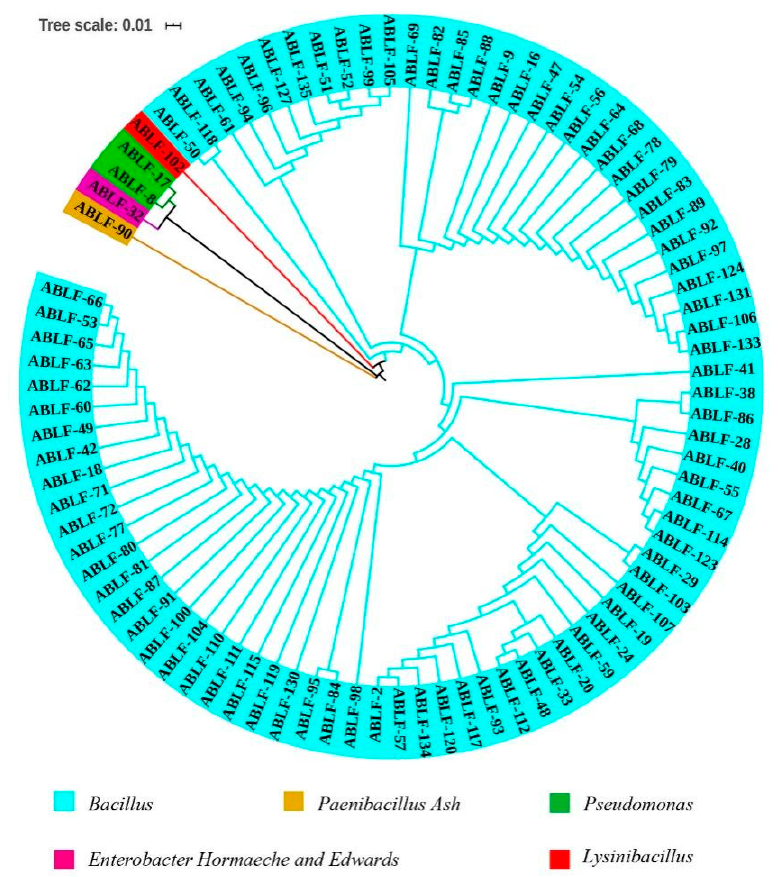
Figure 1. Phylogenetic analysis of candidate antagonistic bacteria against V. dahliae . The 16S rRNA sequences were aligned by ClustalW and phylogenetic tree was constructed with MEGA software (version 7.0, Temple University, Philadelphia, PA, USA) by the neighbor-joining method for 500 bootstraps. Bar 0.01 substitutions per nucleotide position.